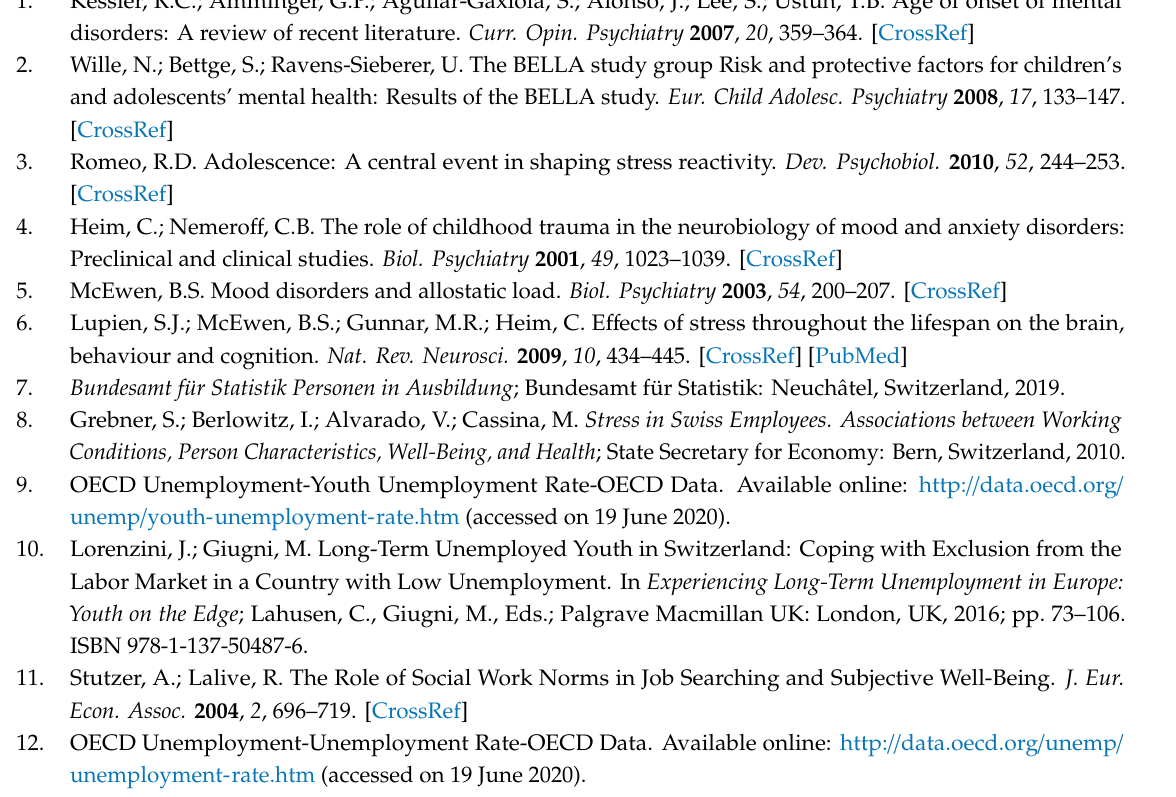
Table S1: Pearson correlation matrix for continuous variables ( N =